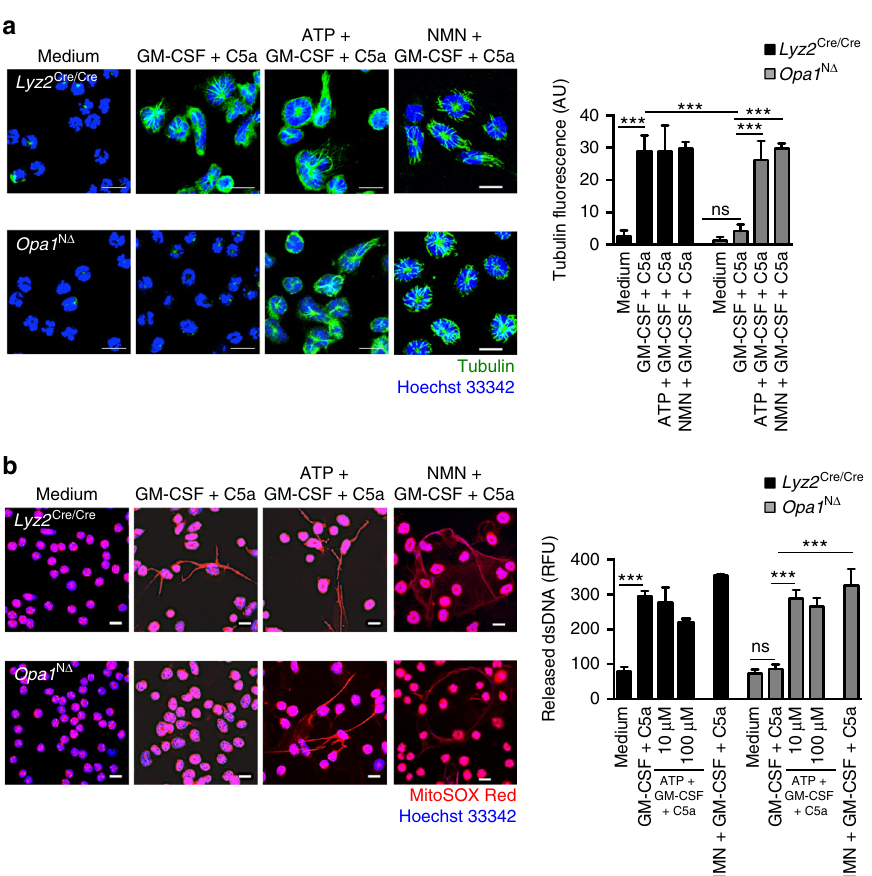
Fig. 4 Exogenous ATP or NMN restore the microtubule network and the ability of activated Opa1 N Δ neutrophils to release DNA. a Confocal microscopy. GM-CSF primed and C5a-stimulated neutrophils of Opa1 N Δ and control mice were pretreated with 100 μ M ATP or 500 μ M NMN. Microtubules were stained with anti- α -tubulin antibody (green). Bars, 10 µ m. Right: quanti fi cation of the microtubule network formation was performed using automated analysis of microscopy images with Imaris software. Values are means ± SEM. n.s., not signi fi cant; *** p < 0.001; n = 5. b Confocal microscopy. GM-CSF primed and C5a-stimulated neutrophils of Opa1 N Δ and control mice were pretreated with 10 and 100 μ M ATP or 500 μ M NMN. Extracellular DNA was stained with MitoSOX ™ Red and the nucleus with Hoechst 33342 (blue). Bars, 10 µ m. Right: quanti fi cation of released dsDNA in supernatants of activated neutrophils. Values are means ± SEM. n.s., not signi fi cant; *** p < 0.001; n = 4. Additional data including microtubule and NET formation induced by other stimuli known to trigger NETs are provided in Supplementary Figs. 7 and